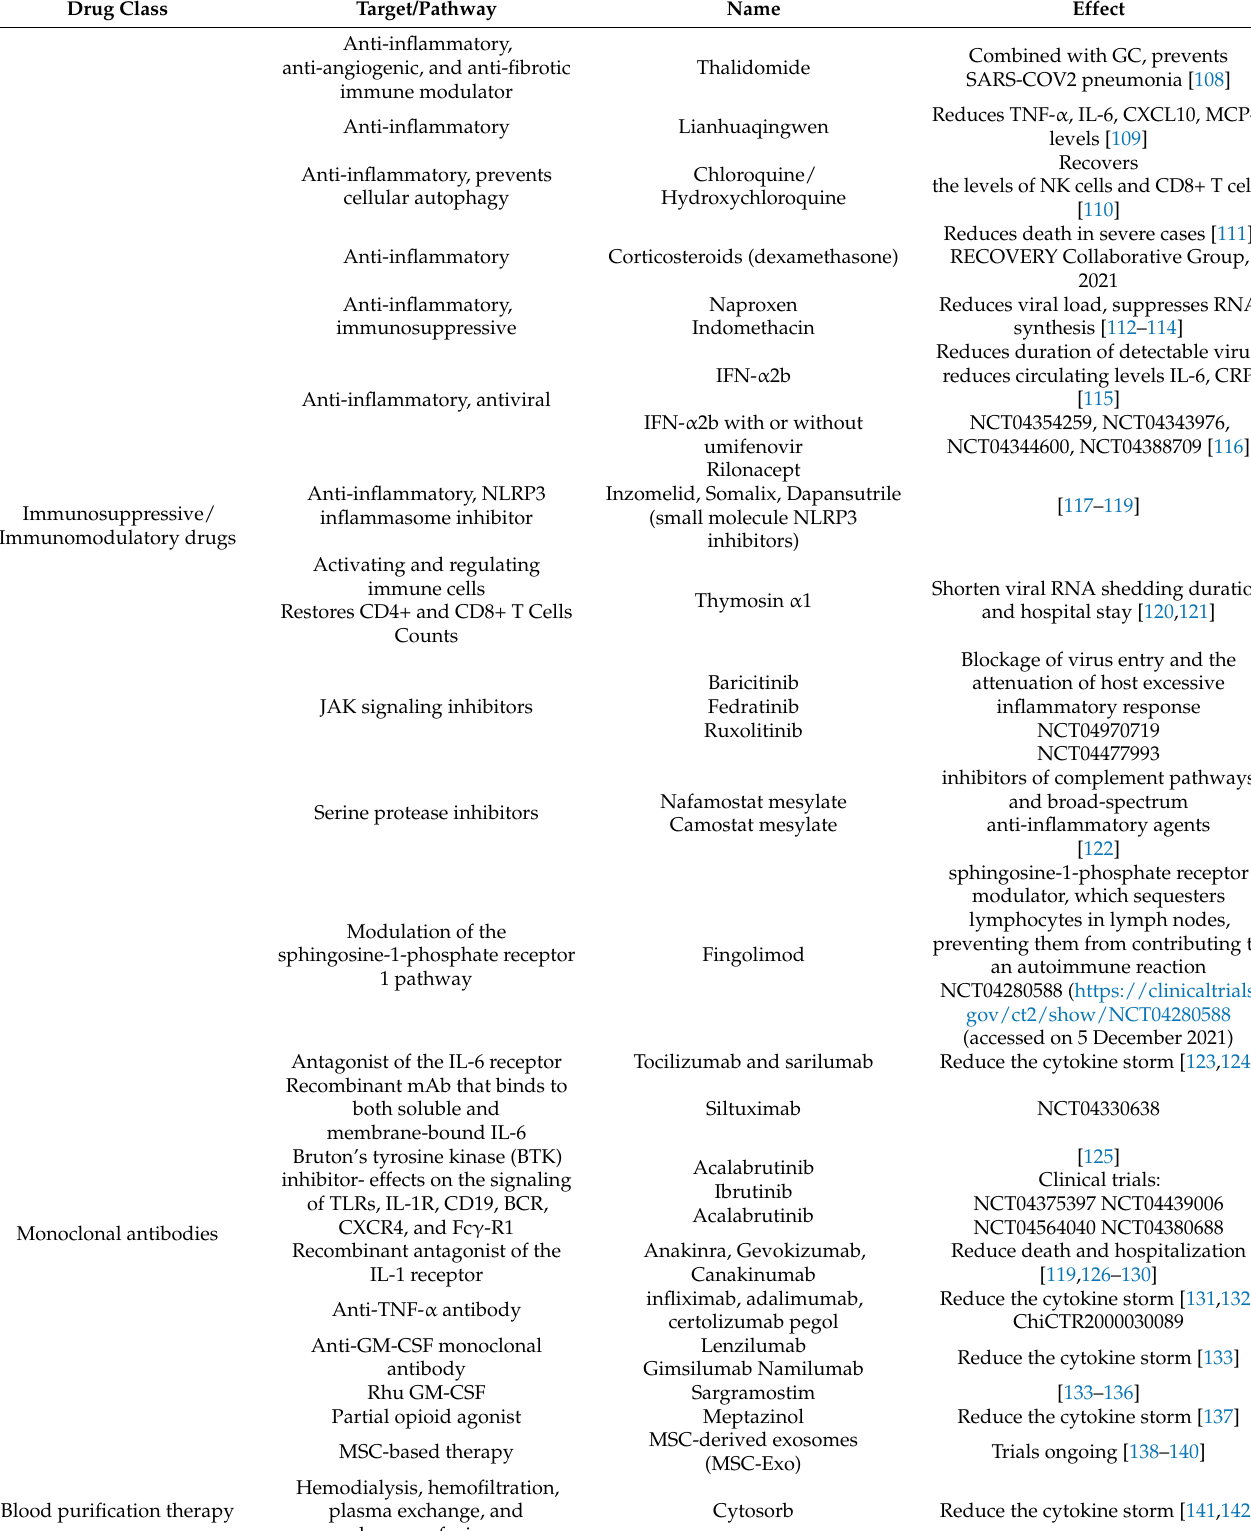
Table 3. Proposed therapeutic strategies for reducing the deleterious effects of exacerbated inflammatory response in COVID-19